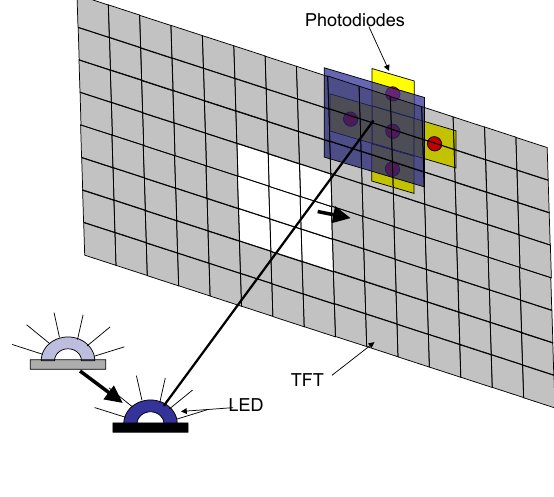
Figure 4. The LED